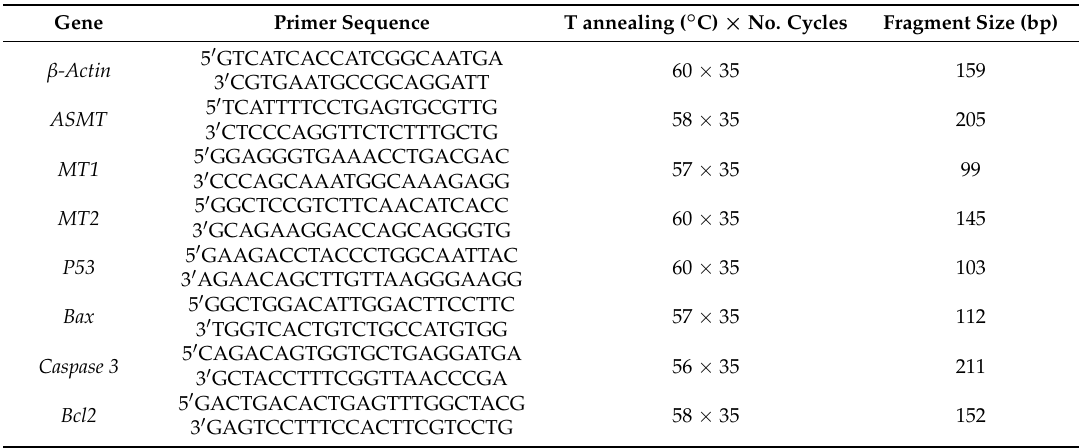
Table 3. Primer sequences and